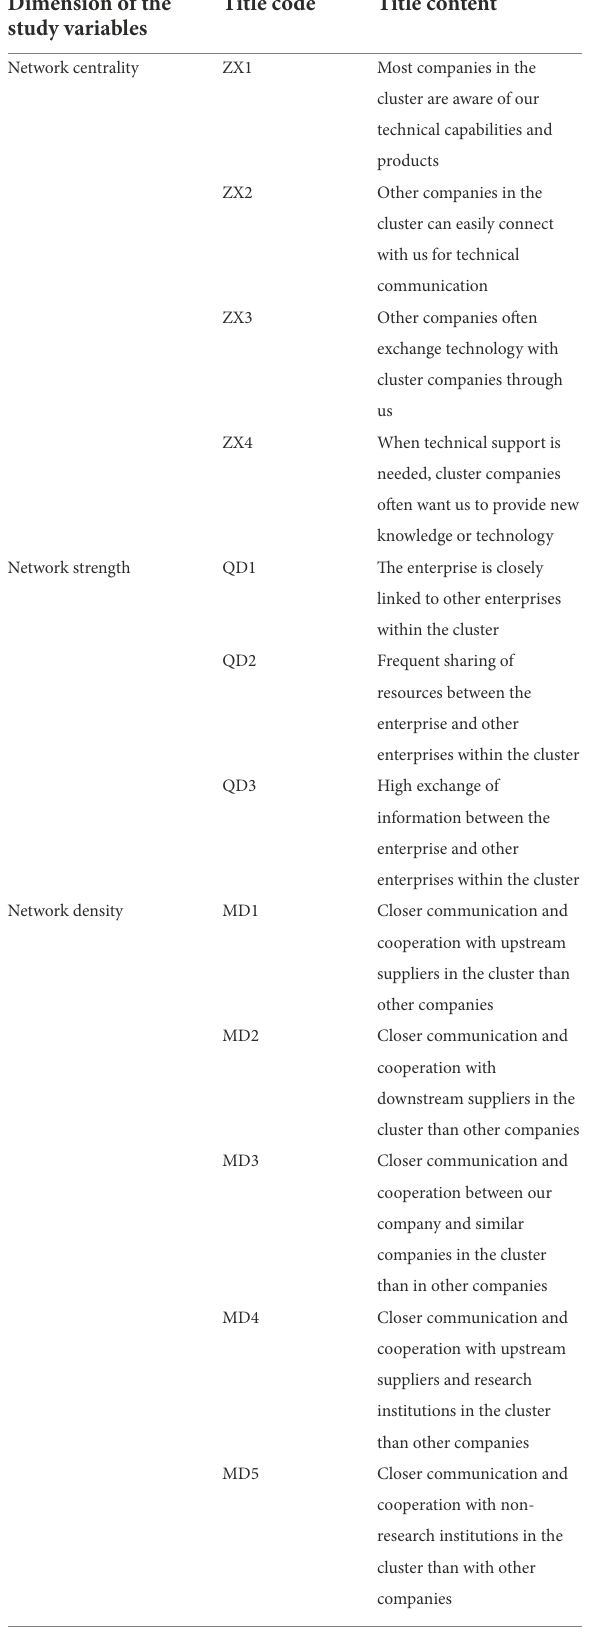
TABLE 1 Cluster firm innovation network